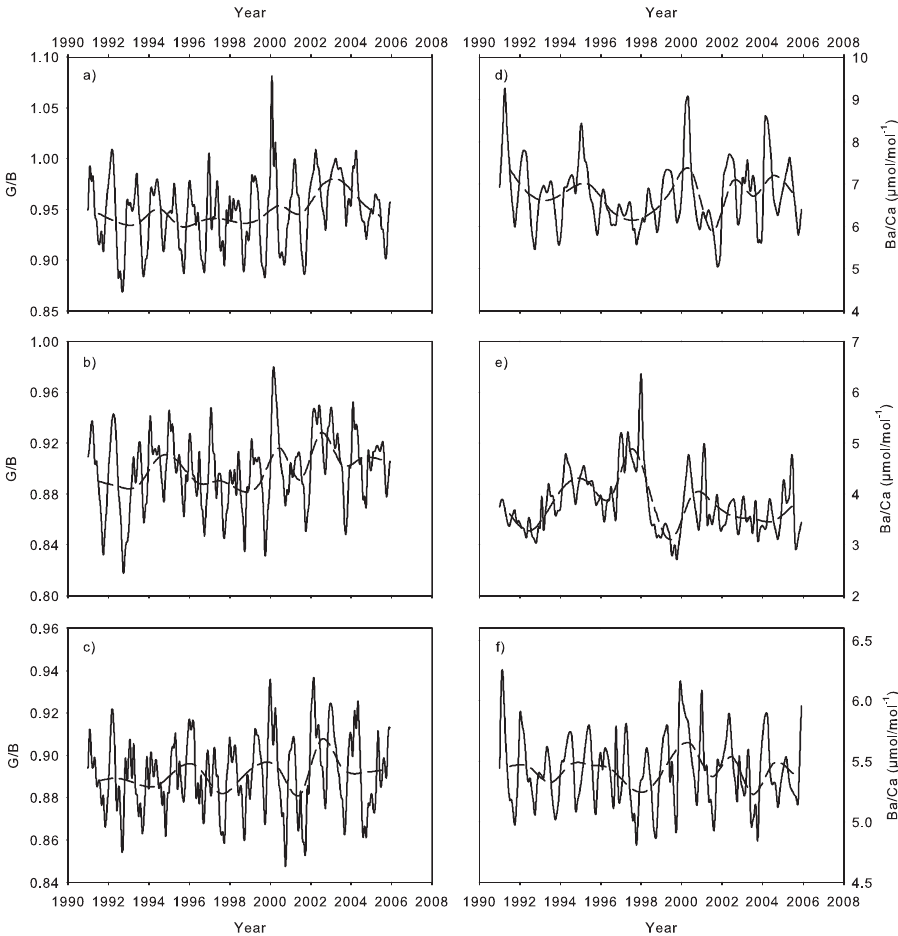
Fig. 4. Monthly G/B ( a , b and c ) and Ba/Ca ( d , e and f ) time-series over the 15yr period between 1991 and 2005 for the three corals MAS1 ( a and d ), ANDRA ( b and e ) and IFAHO ( c and f ). The annual average (dashed line) G/B ( a , b and c ) and Ba/Ca ( d , e and f ) values were calculated by averaging the months January to December for each of the